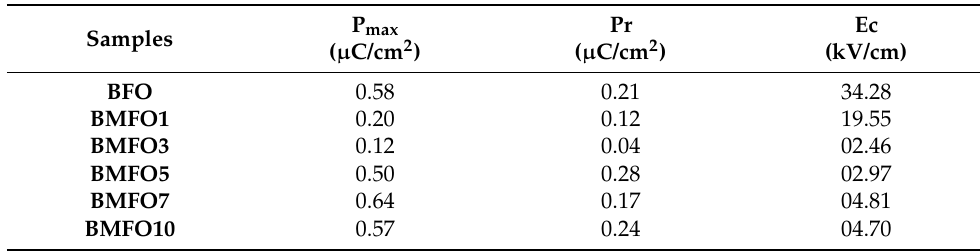
Table 2. Maximum polarization (Pmax), remnant polarization (Pr), and electrical coercivity obtained from the P-E hysteresis